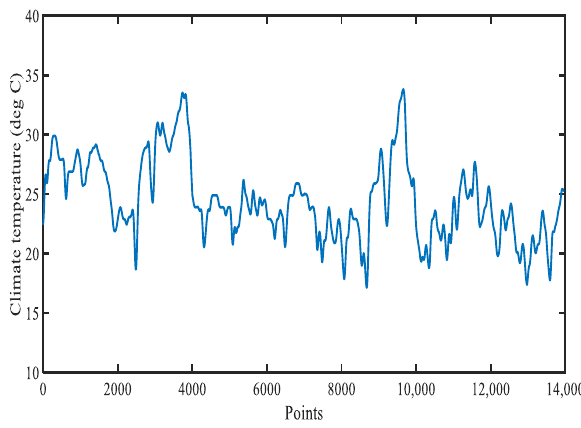
Figure 9. MD value for prediction model input. Figure 10. Actual temperature of the gearbox oil obtained from the supervisory control and data acquisition data.